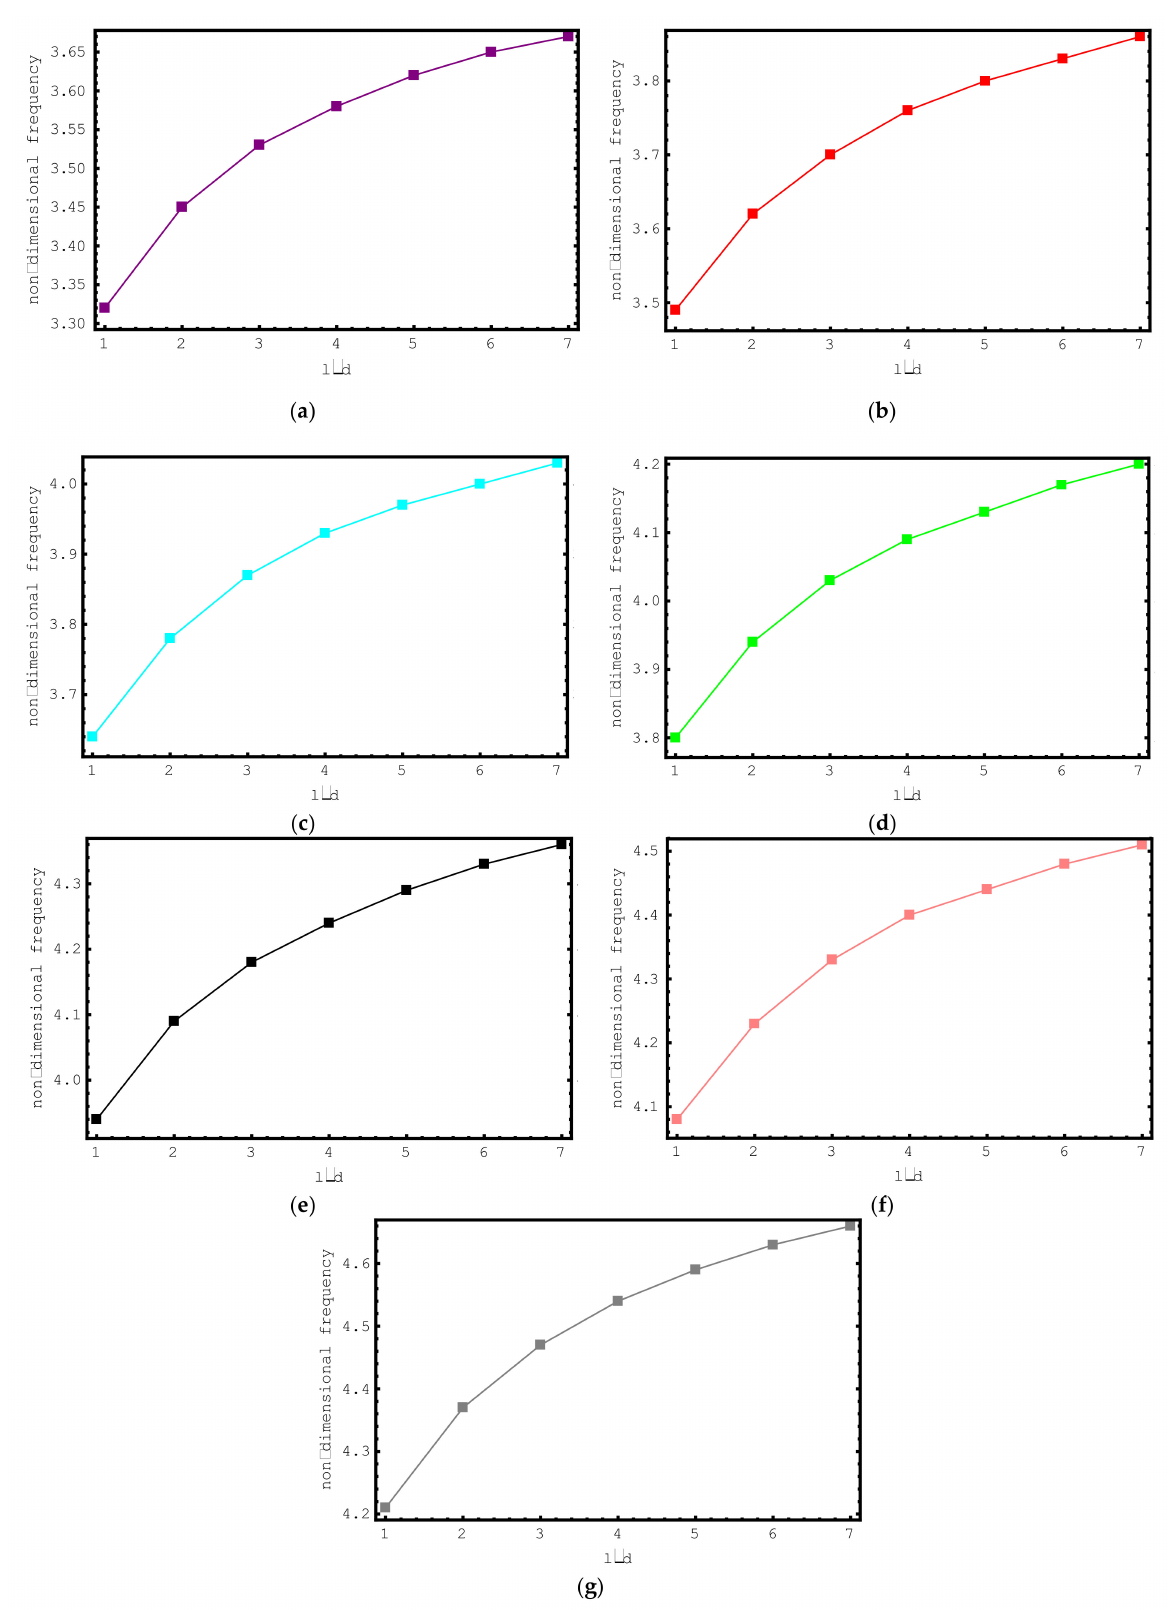
Figure 7. The variations of non-dimensional frequencies of short-fiber-reinforced composite nano- rods versus l / d : ( a ) K = 0 ( b ) K = 1 ( c ) K = 2 ( d ) K = 3 ( e ) K = 4 ( f ) K = 5 ( g ) K =